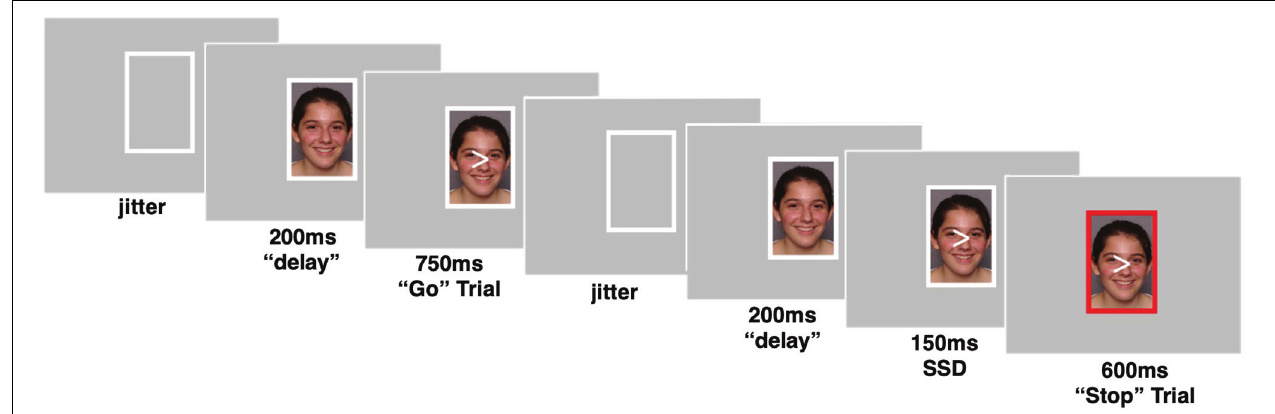
FIGURE 1 | Example trials of the social stop signal task. Go trials when frame enclosing peer’s photo remains white and No-go trials when frame enclosing peer’s photo turns red. Pictures were taken from a publicly available dataset (Egger et al., 2011). Parent permission and actor assent were obtained by a contractual arrangement so that pictures are publicly available for researchers and can be reproduced in scientific dissemination.